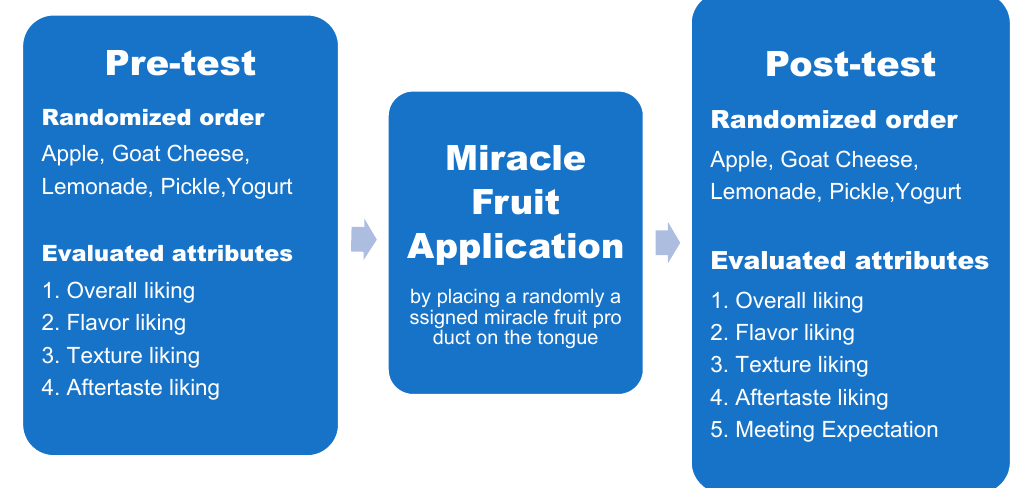
Figure 1. Flowchart of experimental design for individual panelist.